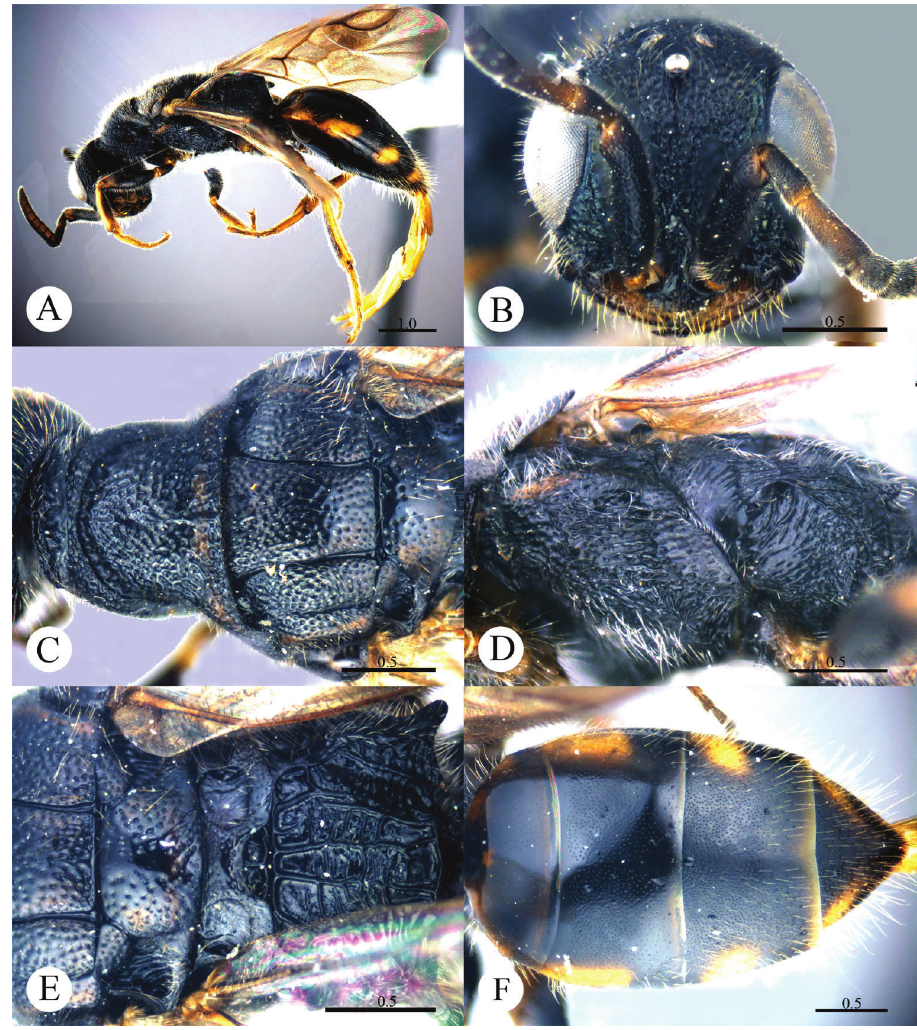
Plate 8. Cleptes niger sp. n., holotype, female. A Habitus lateral B Head anterior C Pronotum and mes- oscutum dorsal D Mesopleuron and metapleuron lateral e Mesoscutellum, metanotum and propodeum dorsal F Metasoma dorsal. Scale bars in